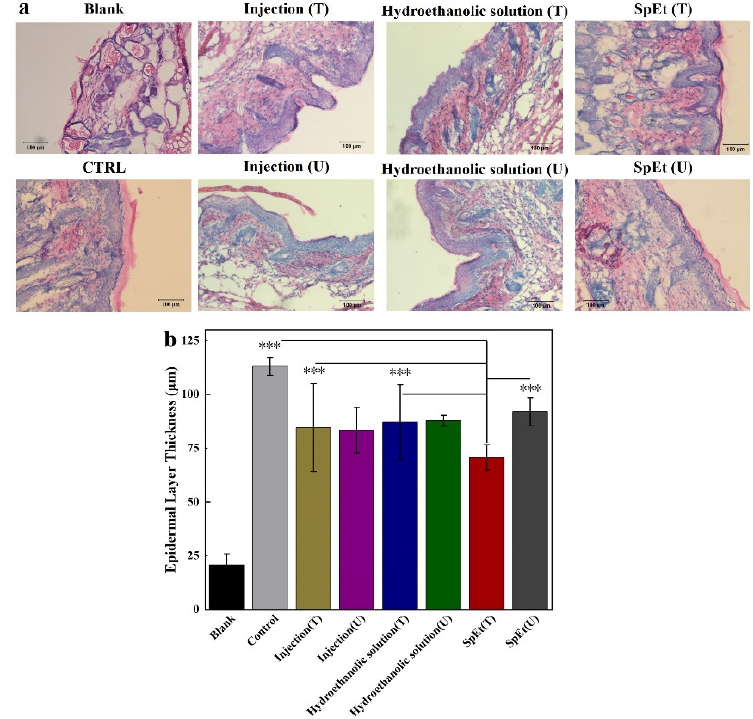
Figure 10. Treatment of psoriasis in vivo. ( a ) Representative H&E staining of cross-sectional slices from the dorsal skin after different treatments on day 14. ( b ) Epidermal thickness of the dorsal skin after different treatments on day 14. T represents the treatment area; U represents the untreated area. *** represents p < 0.001. Each bar represents the mean ± SD ( n = 12). BLANK represents normal (non-psoriatic) mouse skin.